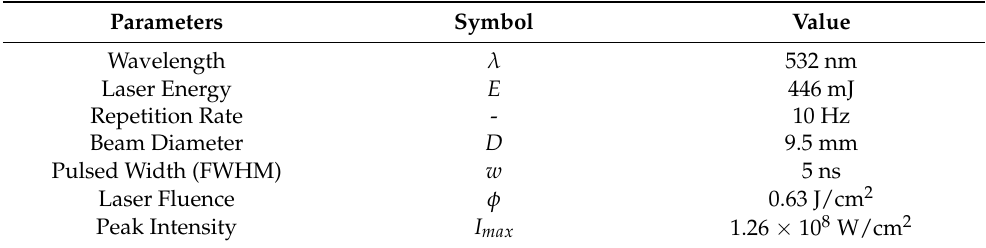
Table 1. Laser parameters used for simulation. Referring to parameters of Nd:YAG Continuum Surelite III model.